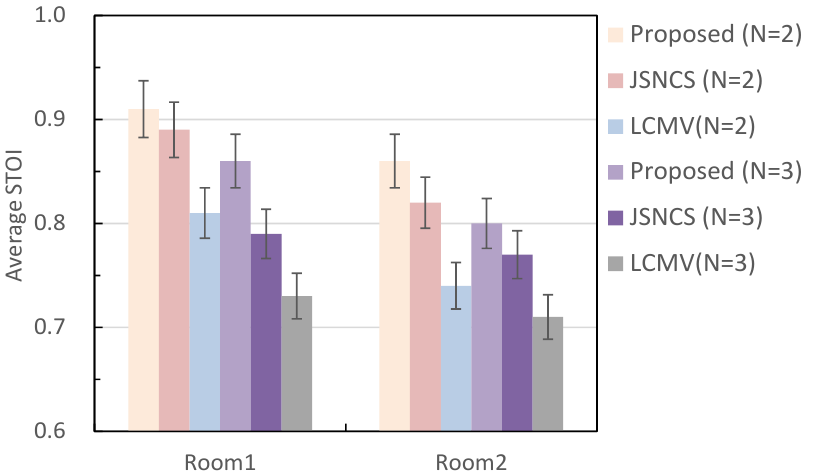
Figure 10. Average STOI of signals separated by the proposed method with or without dereverbera- tion.